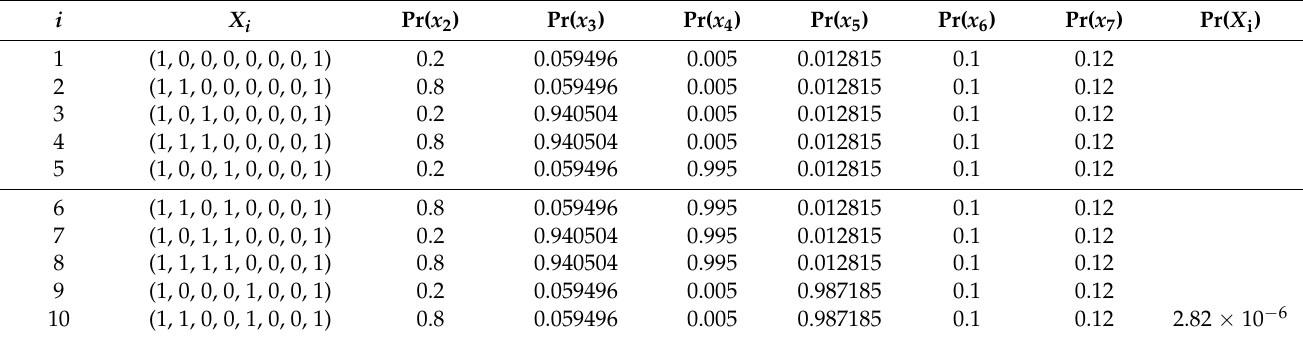
Table 10. Result obtained from the proposed AON